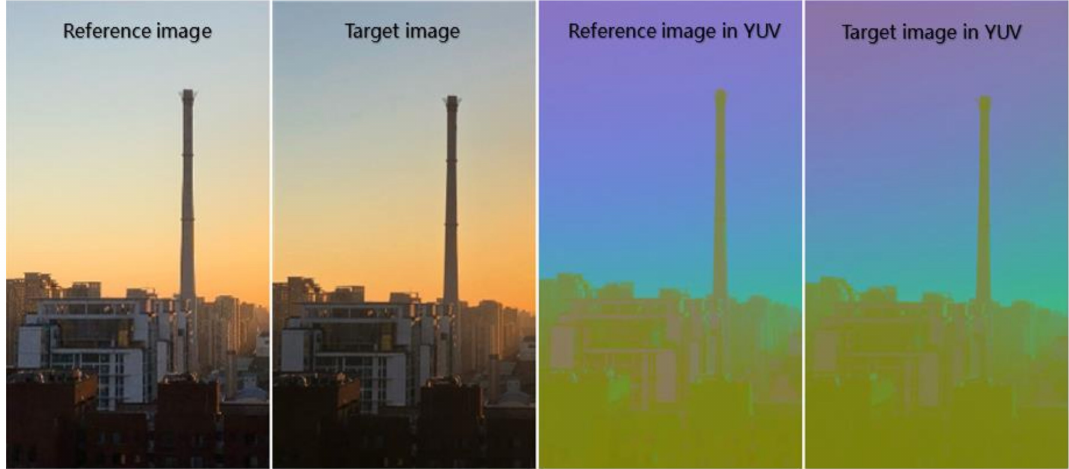
Figure 4. Transform to YUV. From left to right are reference image in RGB. target image in RGB, reference image in YUV and target image in